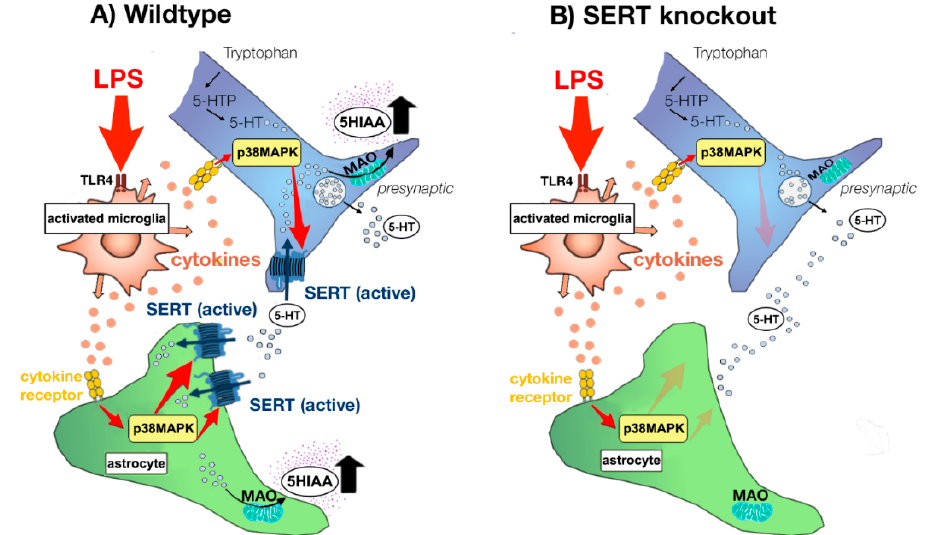
Figure 3. Model of regulation of serotonin (5-HT) transporter (SERT) activity after LPS challenge in SERT Wildtype (SERT +/+ ) rats and SERT Knockout (SERT − / − ) rats. LPS via the binding to toll-like receptor 4 (TLR-4) on microglia produce its’ activation and consequently increase in the release of pro-inflammatory cytokines (e.g., IL-1, IL-6 and TNF- α ). This increase in pro-inflammatory cytokines enhance SERT activity in neurons, as well as increase SERT gene expression in astrocytes. Both processes may be mediated by p38 MAPK-dependent pathways, despite the fact that also independent pathways have been suggested. After reuptake by SERT, 5-HT is packed in storage vesicles or metabolized by monoamine oxidase (MAO). In serotonergic neurons and astrocytes, MAO metabolizes 5-HT to 5-hydroxyindole acetaldehyde and thereafter aldehyde dehydrogenase rapidly metabolizes 5-hydroxyindole acetaldehyde to 5-hydroxyindolacetic acid (5-HIAA). Thereafter, 5-HIAA diffuses outside the cells. Thus, SERT plays, besides controlling the length of the cellular actions of 5-HT, an important role in the formation of its’ metabolite 5-HIAA. As a consequence, LPS-induced SERT activity results in enhanced 5-HT uptake into astrocytes and neurons and thereby promote 5-HT degradation to 5-HIAA in wildtype animals ( A ). Since SERT does not come to expression in SERT knockout animals, LPS cannot increase SERT activity and associated 5-HT metabolism in these animals ( B ), indicating that the SERT is involved in LPS-induced enhancement of 5-HT metabolism in male rats. (Figure adapted after Haase and Brown, 2015